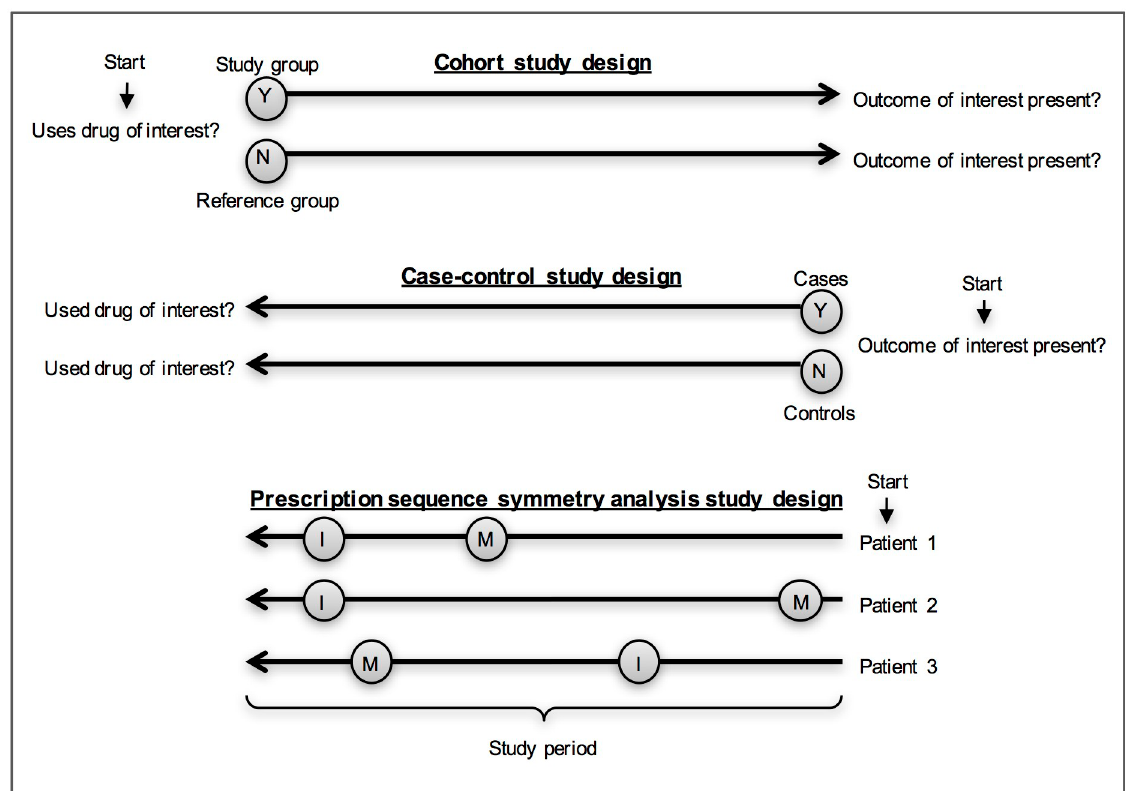
Fig 1. Schematic representation of the cohort-, case-control-, and PSSA study designs. Abbreviations: Y = yes, N = no, I = index drug, and M = marker drug.